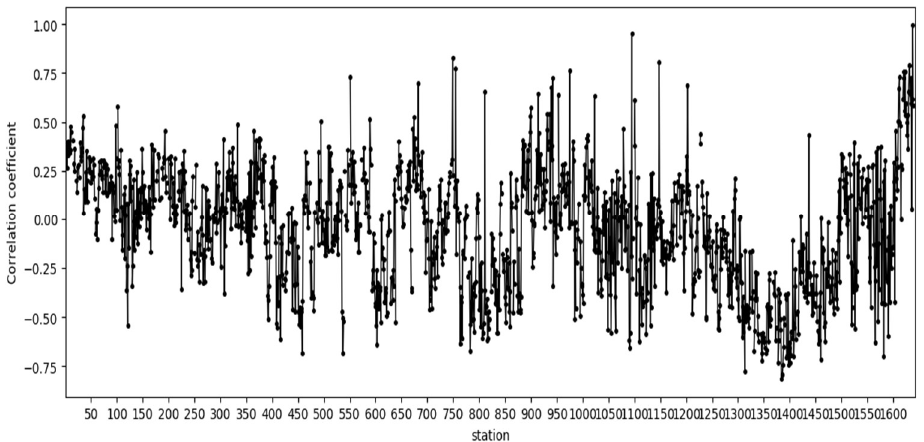
Figure 1. Correlation coefficient (CC) distribution of ground daily NO 2 concentration results and TropOMI products for 1641 sites in China in 2019.